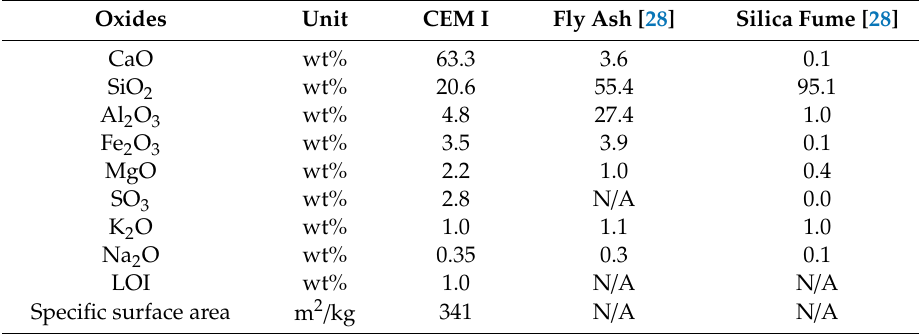
Table 2. Chemical composition of binders.